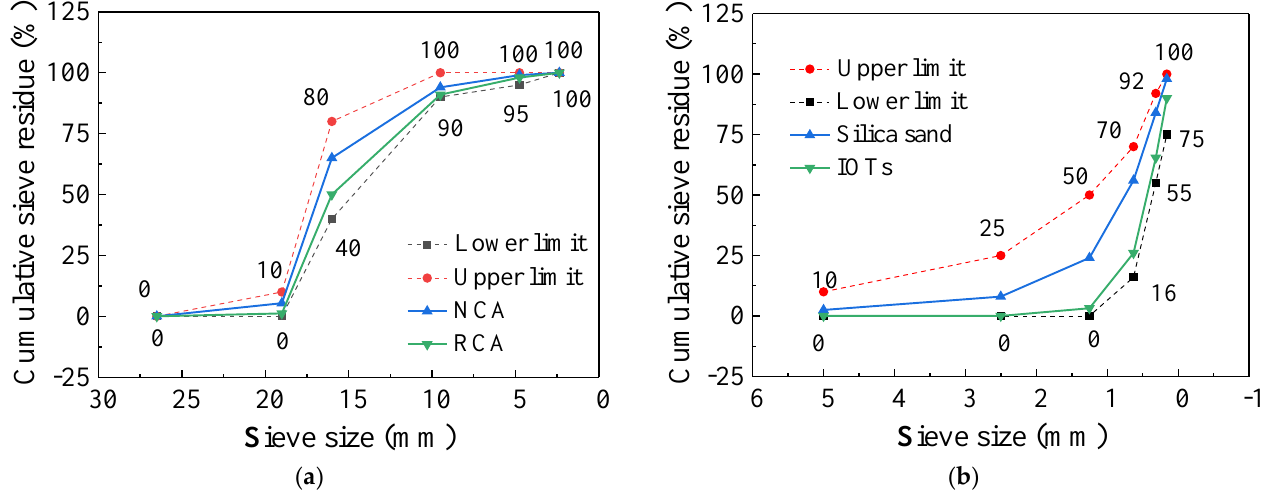
Figure 1. Particle gradation diagram. ( a ) Coarse aggregate. ( b ) Fine aggregate. Table 1. The performance indicators of NCA, RCA, natural sand, and IOTs.